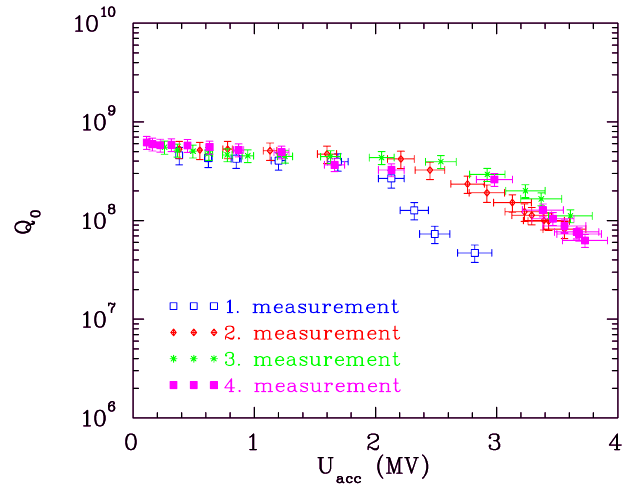
FIG. 33. (Color) The intrinsic Q -value as a function of the effective accelerating voltage. The highest voltage which has been achieved is 3.8 MV.